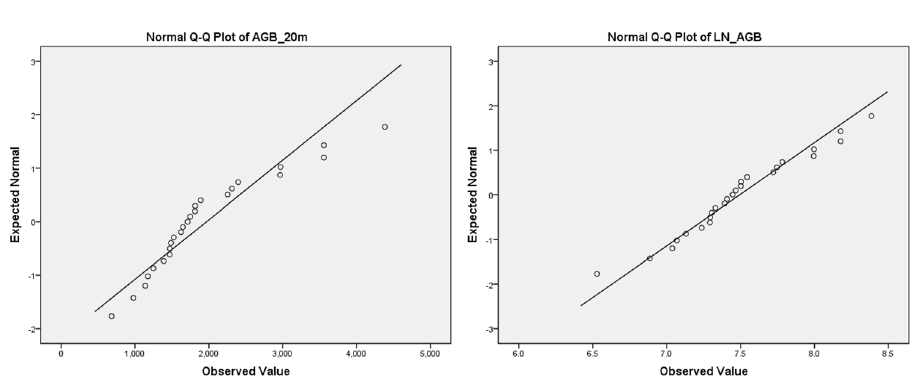
Figure 5. The normal Q–Q plot, in 10 m radius plot size, of ( a ) raw AGB and ( b ) log-AGB. After logarithmic transformation, the AGB (dependent variable) was